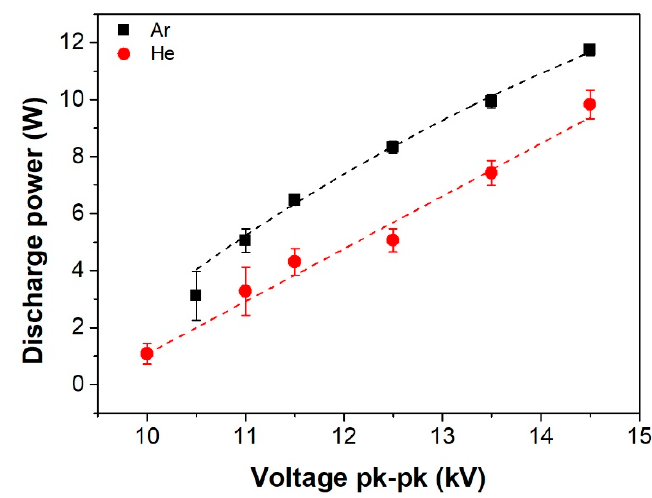
Figure 3. Dependence of the discharge power on applied voltage for argon (black) and helium (red).